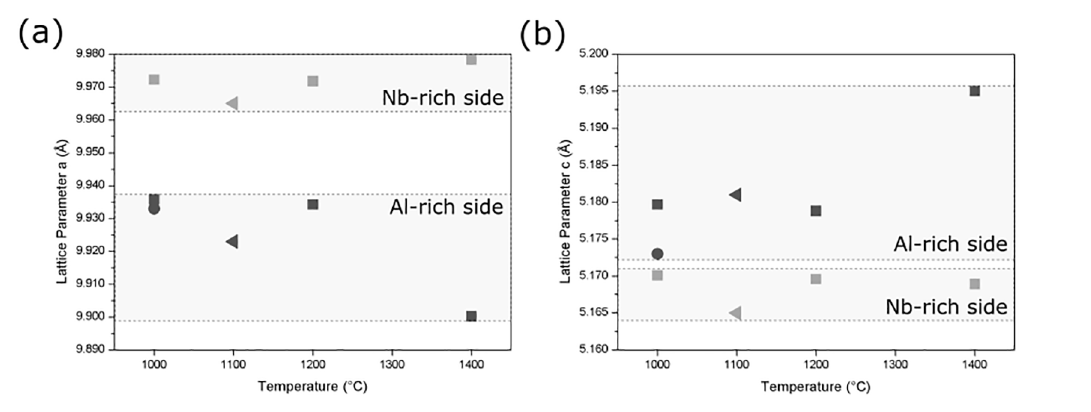
Figure 5. Lattice parameters a “a” and b “c” for the Nb2Al phase as a function of the heat treatment temperature. Symbols are from Kokot et al. 21 (◄), Joubert 37 (●) and this work (■).